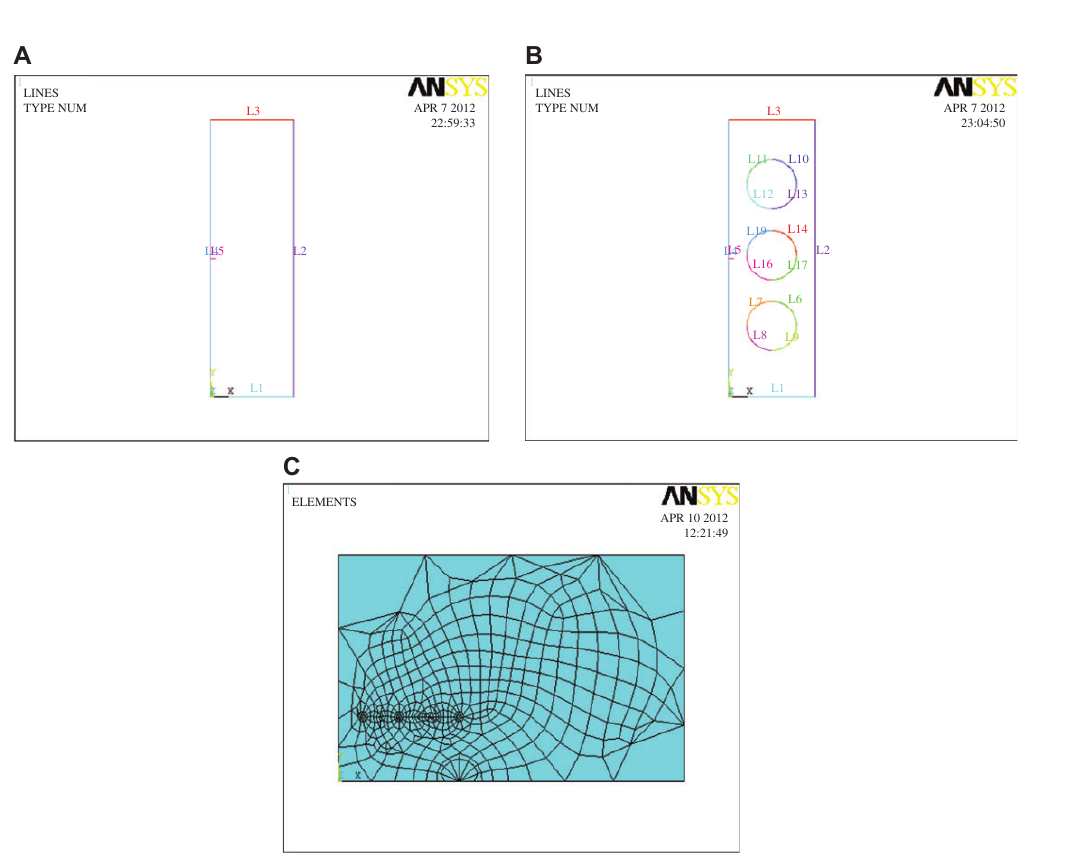
Figure 2 (A) Schematic of a SENT specimen for A384 alloy composite. (B) Schematic of a SENT specimen for particulate-filled A 384 alloy composites. (C) Mesh pattern for stress intensity factor analysis in